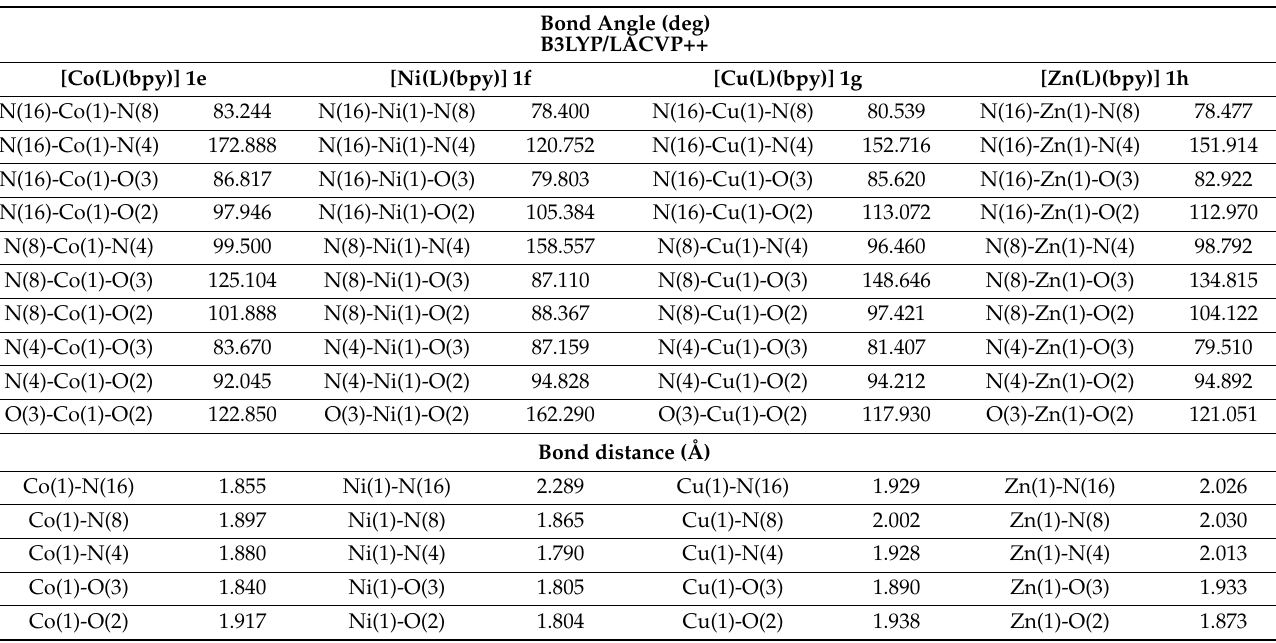
Table 8. Selected optimized geometry parameters of metal(II) complexes 1 ( e – h ) by B3LYP method using LACVP++ basis